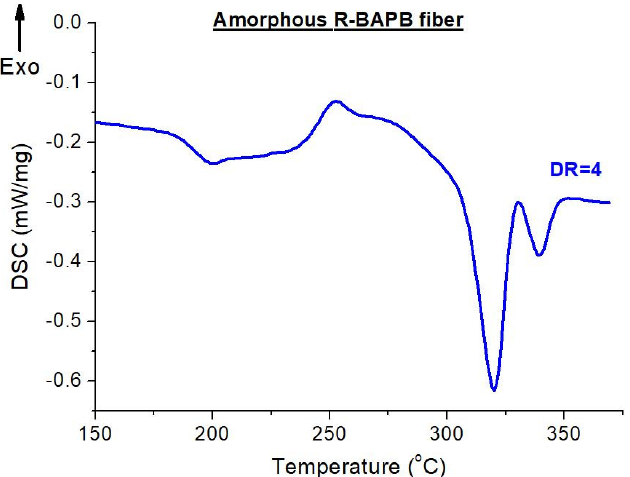
Figure 10. DSC thermogram of the amorphous polyimide R-BAPB fiber after orientation drawing (DR = 4).